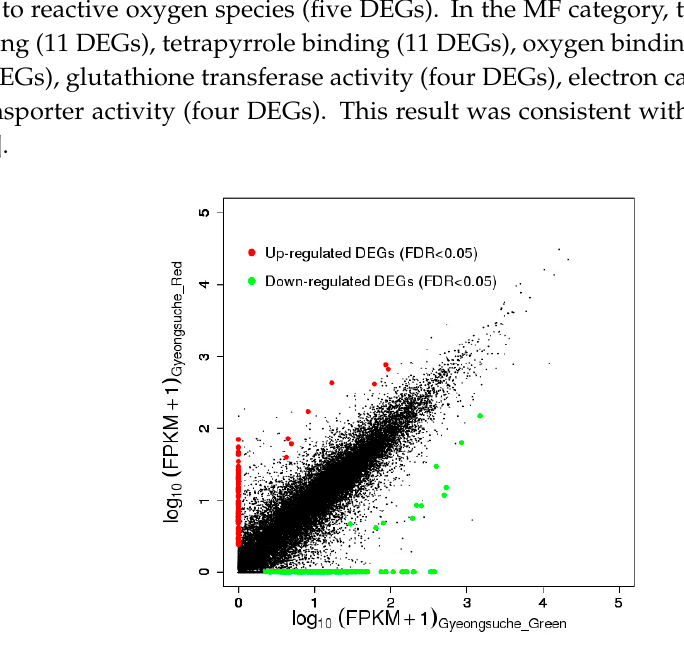
( DFR ), leucoanthocyanidin dioxygenase ( ANS ), UDP-glucose: flavonoid 3-O-glucosyltransferase ( UF3GT ), anthocyanin 5-O-glucosyltransferase ( 5GT ), and transparent testa 19 ( TT19 )) as well as several phenylpropanoid biosynthetic genes (cinnamate-4-hydroxylase ( C4H ) and hydroxycinnamoyl-CoA shikimate / quinate hydroxycinnamoyl transferase ( HCT )) were expressed at higher levels in red